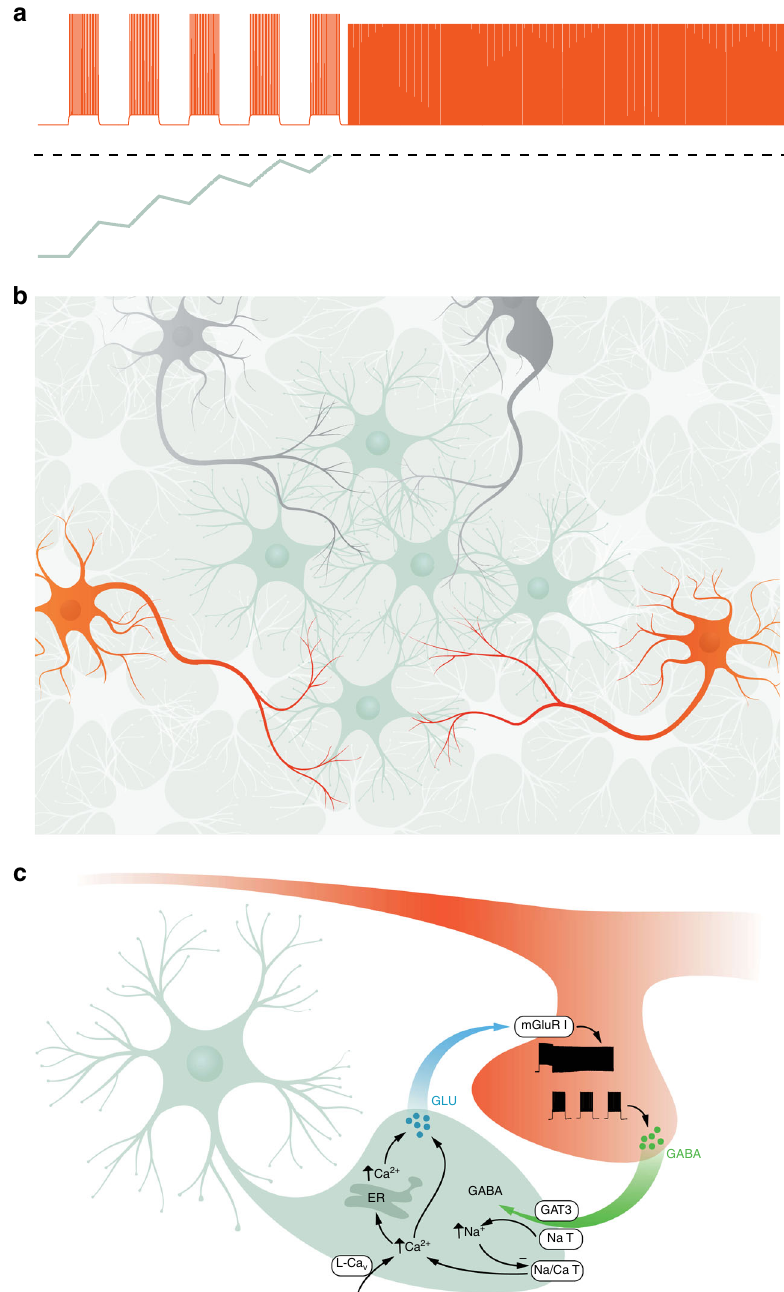
Fig. 6 Schematic model for the interaction between astrocytes and NPY interneurons to induce barrage fi ring. a Repeated spiking (orange trace) of an NPY interneuron eventually results in barrage fi ring. As shown schematically, spikes are evoked by 1-s-long step depolarizations; only fi ve steps are shown, though normally many more are required. During barrage fi ring, spikes emanate from the distal axon, resulting in somatic spikes with no apparent underlying depolarization. Evoked spikes (i.e., during the step depolarizations) lead to step increase of a hidden variable (green trace, corresponding to an unknown biomolecule in the astrocyte) that decays as a leaky integrator, modeled here using a decay time constant of ~7.7 s. When this hidden variable reaches a threshold (dashed line), it results in processes that elicit barrage fi ring, following a delay, as shown here. Vertical scale is arbitrary. b NPY interneurons (orange) and other interneurons (gray) overlap with astrocytes (green and white), but only NPY interneurons are capable of generating barrage fi ring. The axons of multiple NPY interneurons may interact with the fi ne processes of many astrocytes, many of which may be interconnected via gap junctions. c Schematic showing a model of the potential molecular steps in astrocytes leading to barrage fi ring in NPY interneurons. See text for details. GLU glutamate, ER endoplasmic reticulum, GAT3 GABA transporter, NaT sodium transporter, Na/Ca T sodium/calcium transporter, mGluR I group I metabotropic glutamate receptor. Illustrations in Fig. 6b, c were drawn by Julia